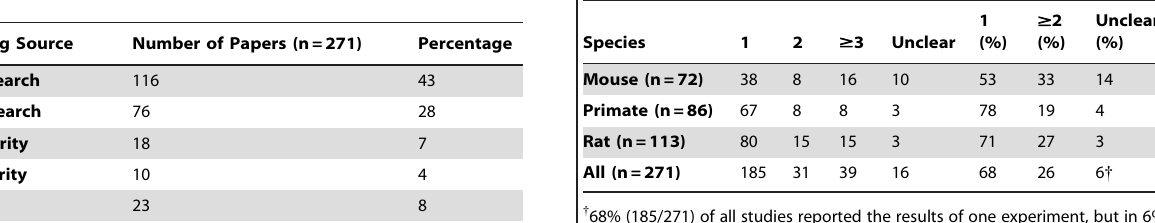
Table 2. Number of studies reporting funding source classified by main funding body.